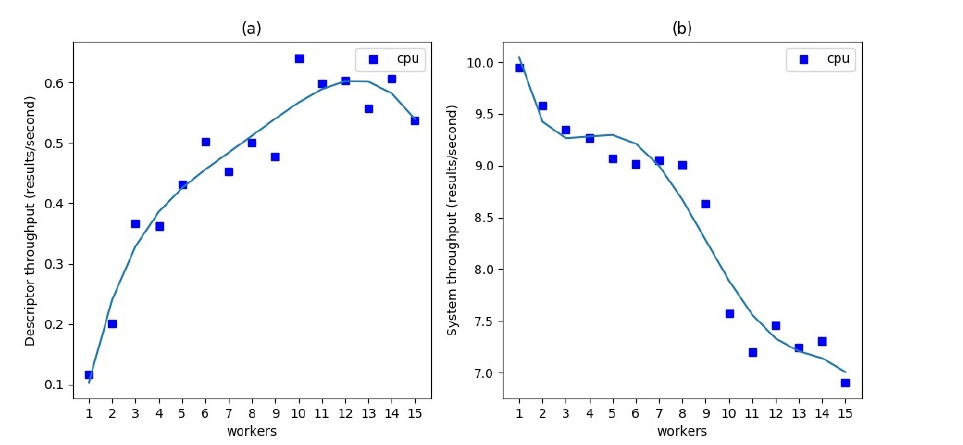
Figure 7. Scalability of a single Descriptor chain increasing the number of workers in CPU mode. ( a ) Descriptor throughput. It indicates the number of feature updates per second. ( b ) System throughput. It indicates the number of output messages per